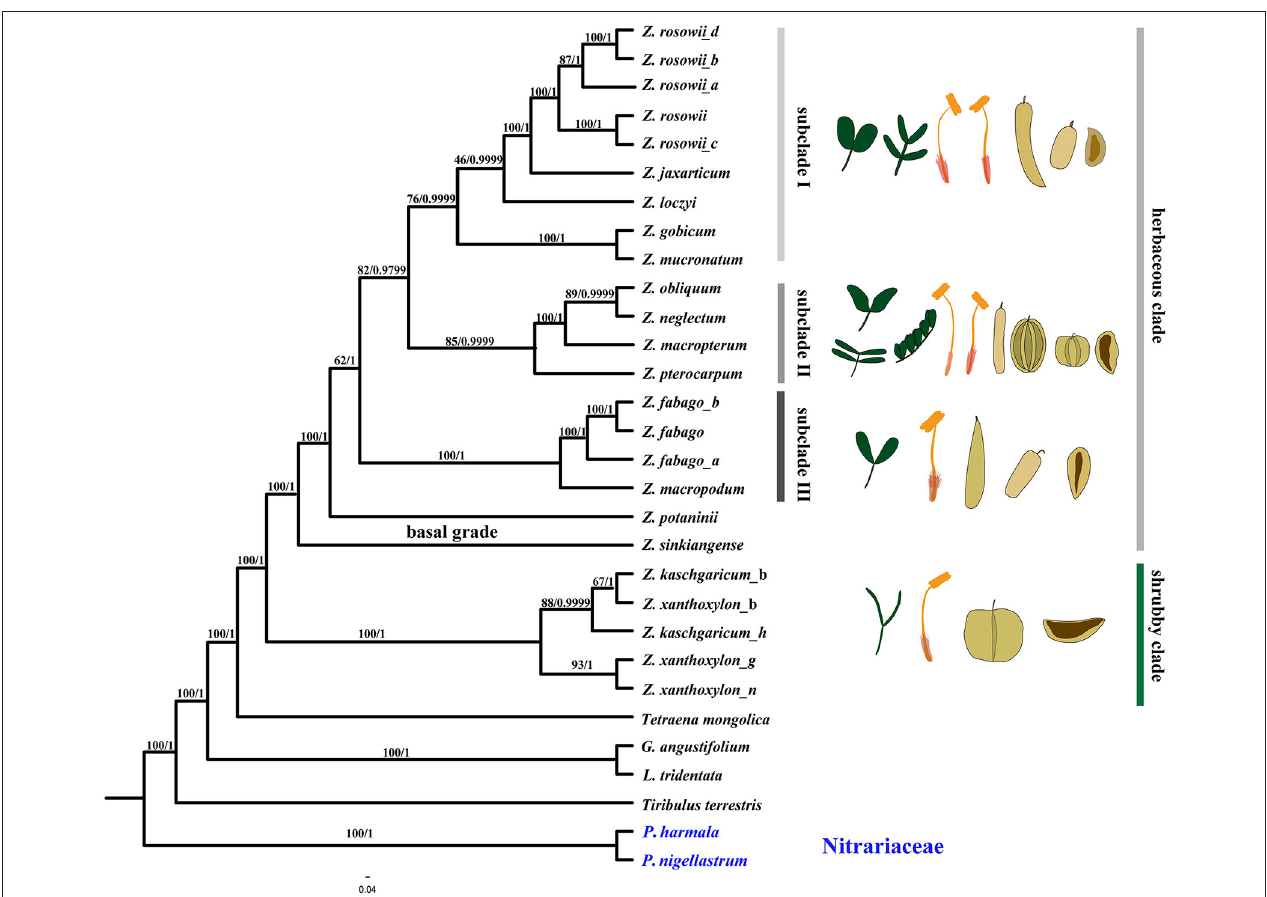
FIGURE 7 | Phylogenetic relationships of Zygophyllum and its allies obtained from an ML and BI analysis of the complete cp genome. Numbers above the branches are the bootstrap values and Bayesian posterior probabilities, respectively.